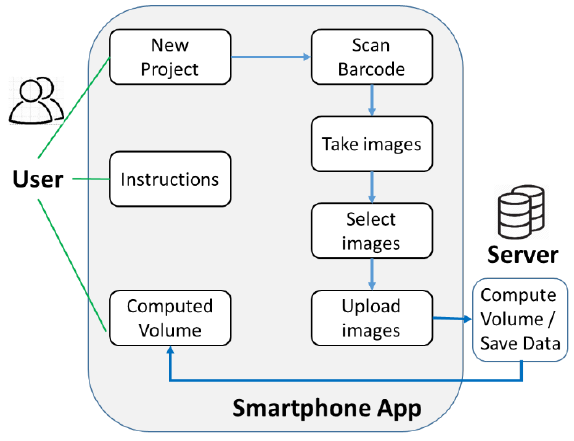
Figure 2: General workflow of the waste bin volume detection App